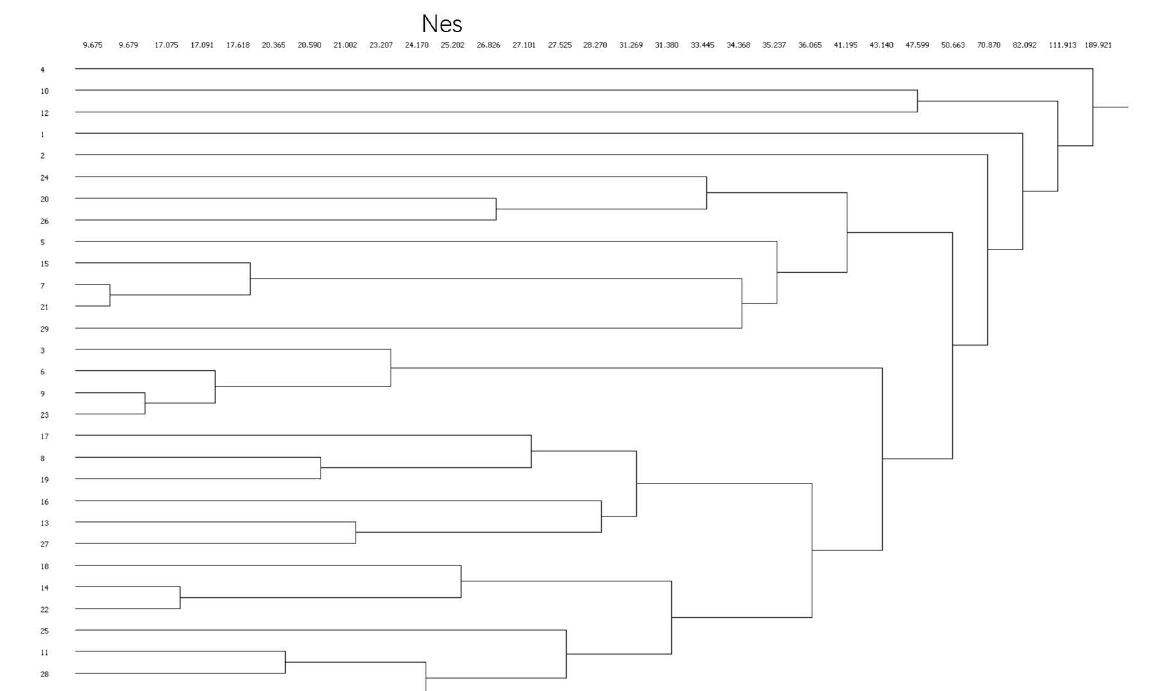
Figure 8. Roles and Structures Analysis. Note: Structure partitioning results based on Concor method are shown on the top; results based on Euclidean method are shown on the